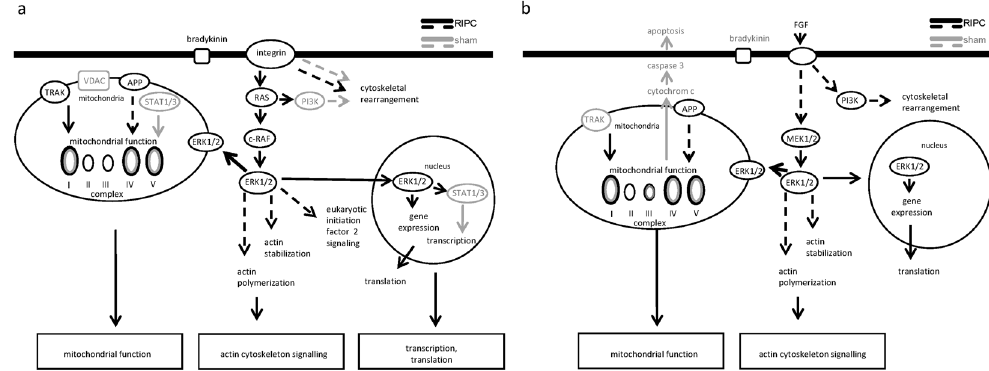
Figure 8. In-silico pathway analysis. Independently of lysis and digestion methods, all proteins detected at a ≥ 2-fold higher expression/phosphorylation with RIPC versus with sham and those exclusively detected in one group (RIPC/sham) at early reperfusion in human and porcine LV biopsies were considered for an Ingenuity pathway analysis. This pathway analysis does not distinguish between activation (phosphorylation) or expression of the detected proteins. ( a ) Proteins having higher expression/phosphorylation with RIPC than with sham in human LV biopsies at early reperfusion after cardioplegic ischemic arrest are related to mitochondrial function, cytoskeleton and transcription/translation. ( b ) Proteins having higher expression/phosphorylation with RIPC than with sham in porcine LV biopsies at early reperfusion after coronary occlusion are related to mitochondrial function and cytoskeleton. Proteins marked in black had higher expression/phosphorylation with RIPC than with sham, and proteins marked in grey had higher expression/phosphorylation with sham than with RIPC. Continuous arrows are reflecting direct relations and broken arrows are reflecting indirect relations. APP: amyloid precursor protein, c-RAF: rapidly accelerated fibrosarcoma, ERK1/2: mitogen-activated protein kinase 3/mitogen-activated protein kinase 1, STAT1/3: signal transducer and activator of transcription 1/3, TRAK: trafficking kinesin protein, VDAC: voltage-dependent anion